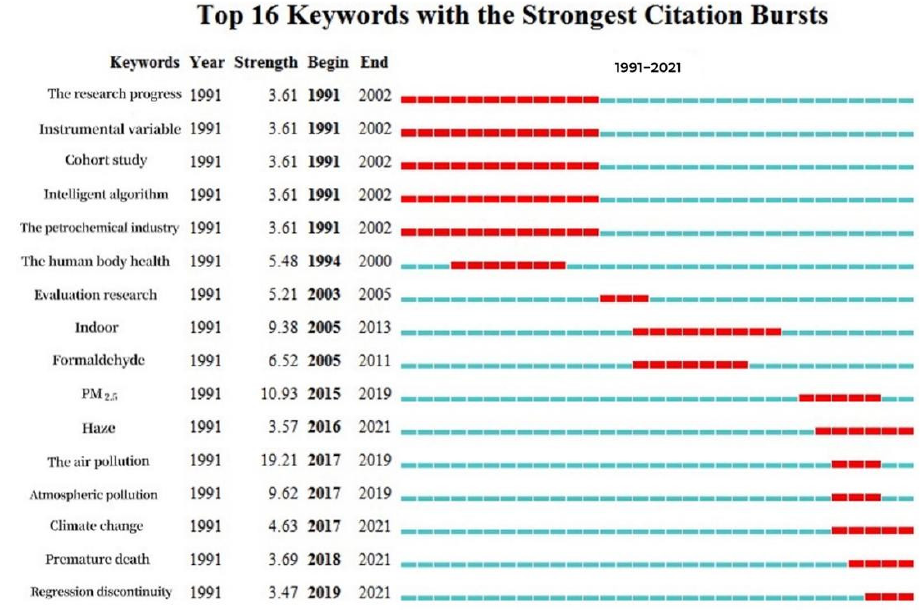
Figure 10. Chinese literature keyword bursts.